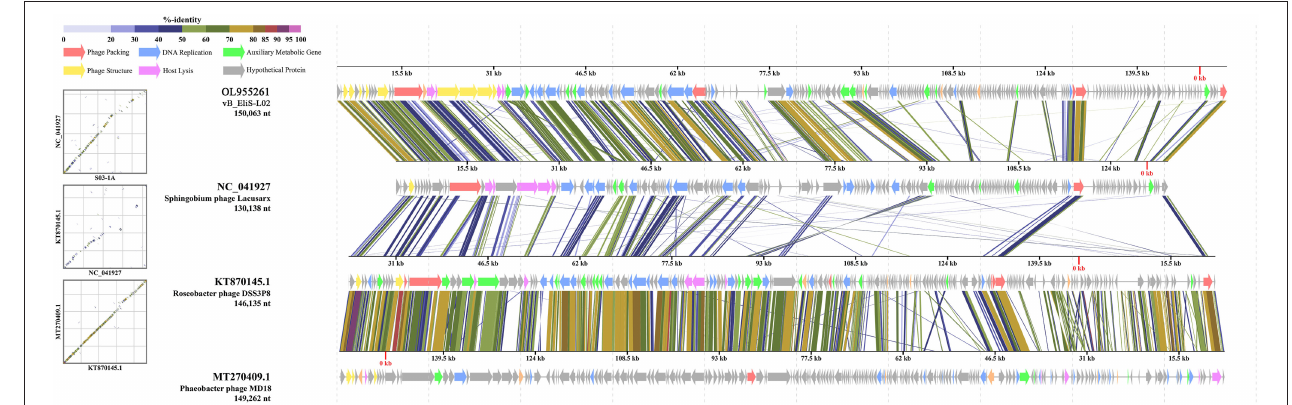
FIGURE 3 | Genome comparisons between phage vB_EliS-L02 and typical Cbk-like phages. The ORFs are represented by arrows. The predicted functional domains represented arrows in different colors. The shading below each genome indicates sequence similarities between the